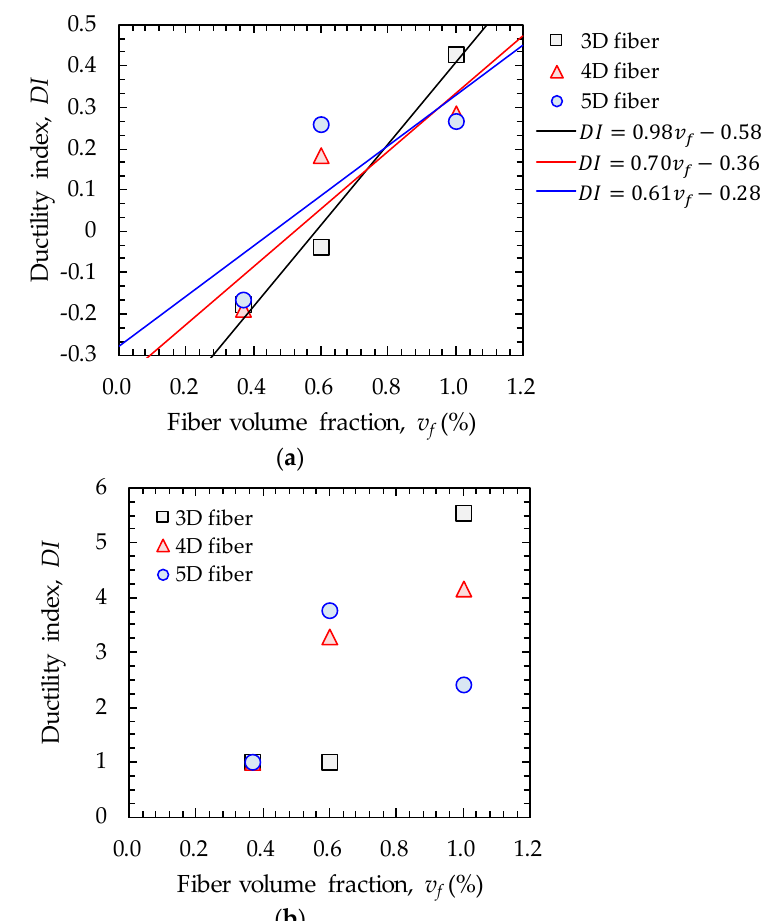
Figure 10. Summary of ( a ) load ductility index and ( b ) deflection ductility index.